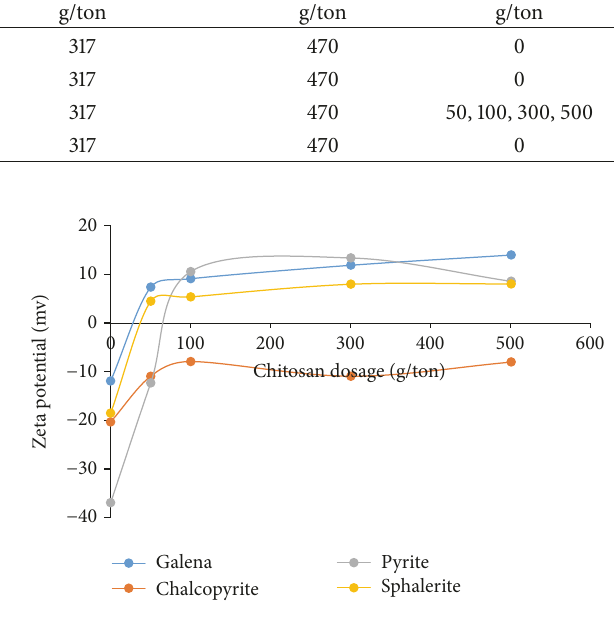
Figure 6: Zeta potential measurements of mineral suspensions as a function of chitosan dosage at pH ∼